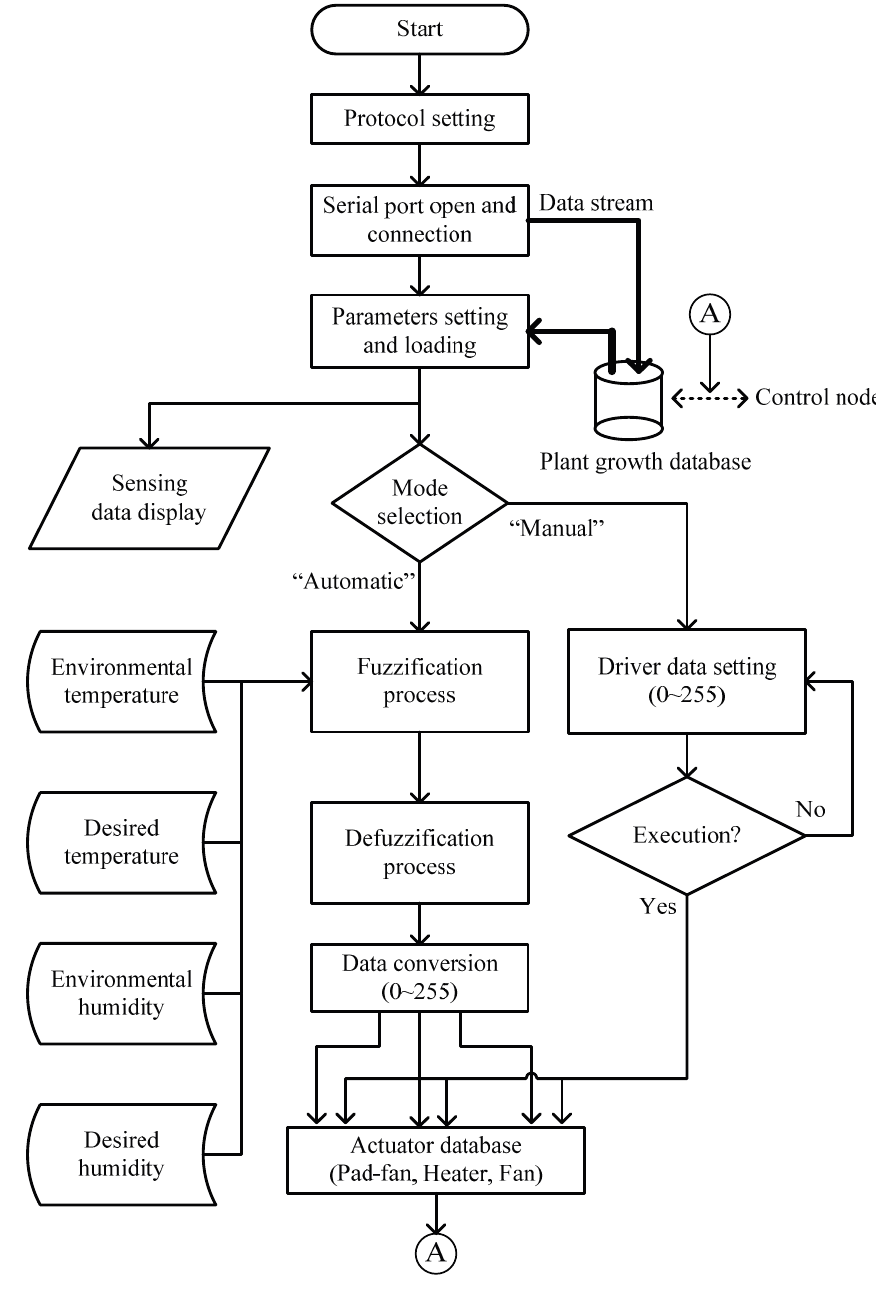
Figure 7. Flowchart of GUI program